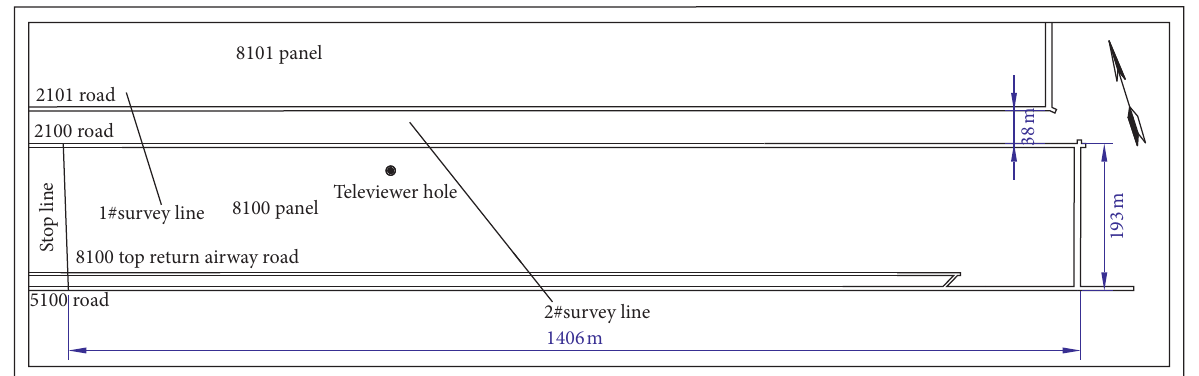
Figure 2: Panel layout.